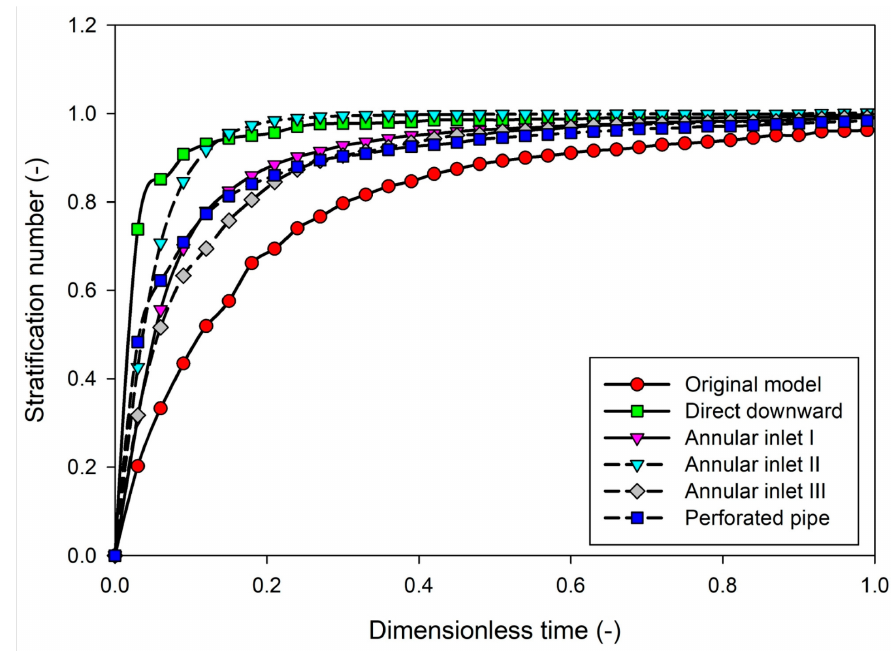
Figure 9. The stratification numbers of the modified inlet pipe